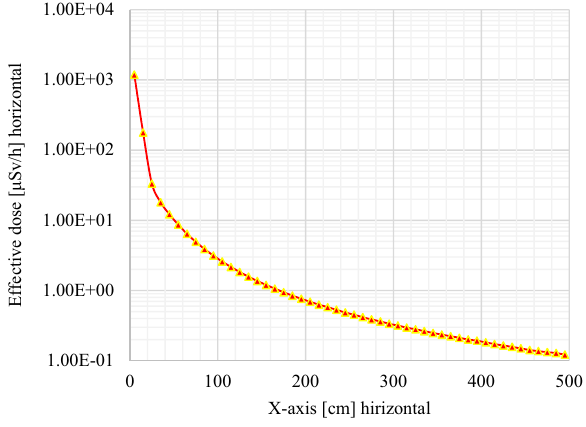
Figure 5. Effective dose (horizontal profile or x-axis) investigated from the tally for output results where the interval 0–23.70 cm represents the DSRSs container radius and the interval 23.70–500.00 cm corresponds to the closest area to the waste package to be disposed of.